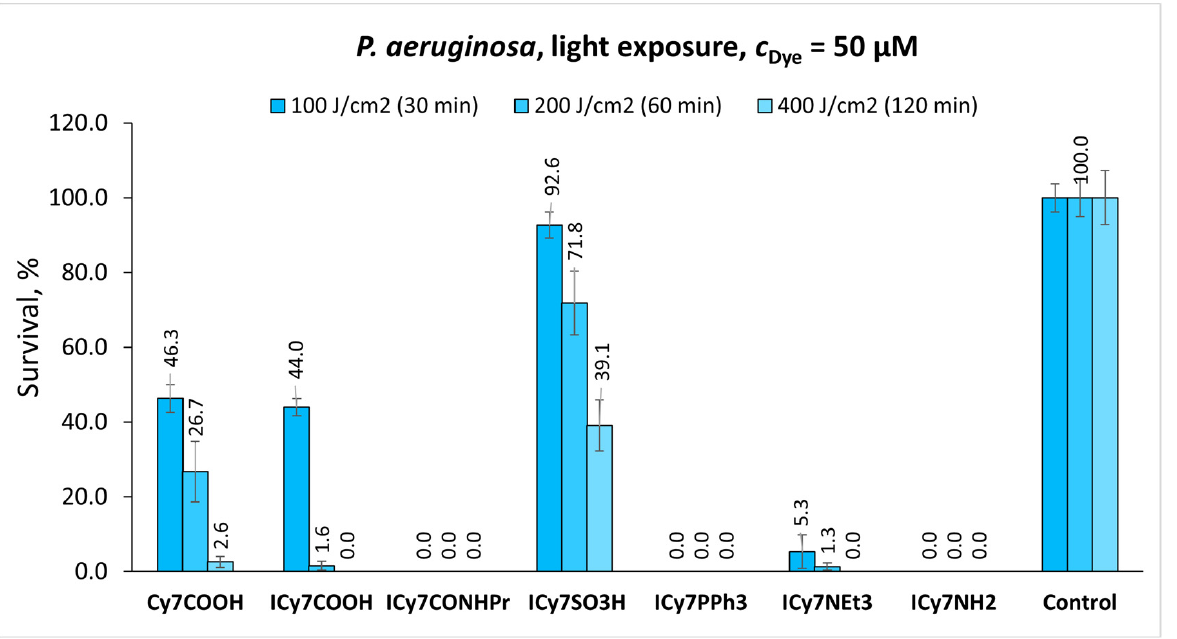
Figure 8. Survival of P. aeruginosa at ( c Dye = 50 µM in saline containing 0.7% DMSO), when exposed to 100 J/cm 2 (30 min), 200 J/cm 2 (60 min), and 400 J/cm 2 (120 min) light doses. Similar to Gram-positive S. aureus , both types of Gram-negative bacteria are most resistant towards ICy7SO 3 H exhibiting the survival of 60.5% on E. coli and 39.1% on P. aeruginosa (light dose 400 J/cm 2 ). Remarkably, this dye was found to be much less phototoxic than the non-iodinated Cy7COOH (survival 18.6% for E. coli and 2.6% for P. aeruginosa at 400 J/cm 2 ). The most effective photokillers are ICy7CONHPr , ICy7PPh 3 and ICy7NH 2 , while ICy7NEt 3 and ICy7COOH are a bit less phototoxic. All these dyes are more active towards E. coli and P. aeruginosa at 100 J/cm 2 (Figures 5 and 7) compared